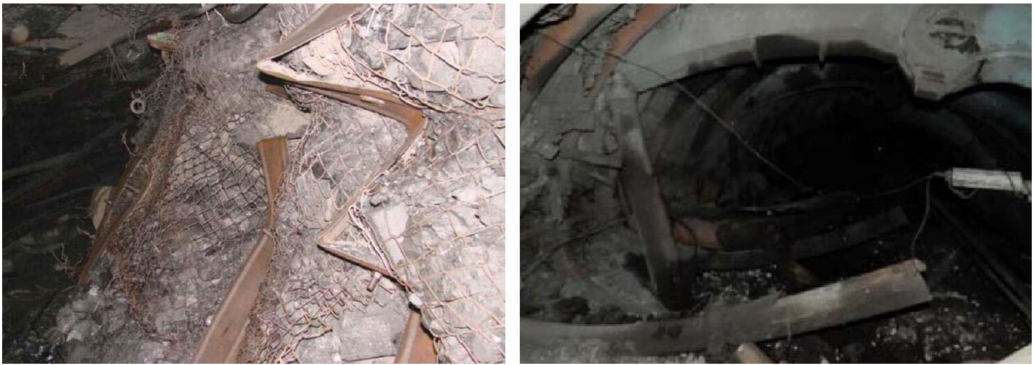
Figure 1. Damage to the roadway caused by a